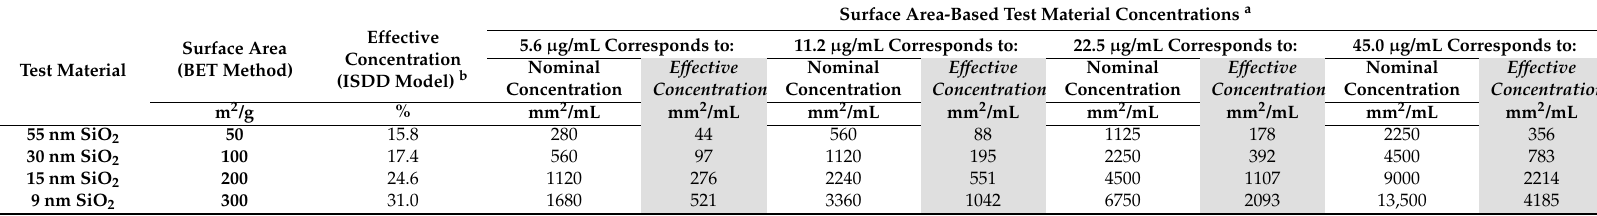
Table 2. Particle mass–based test material concentrations juxtaposed with corresponding nominal and effective surface area–based concentrations of the test materials.